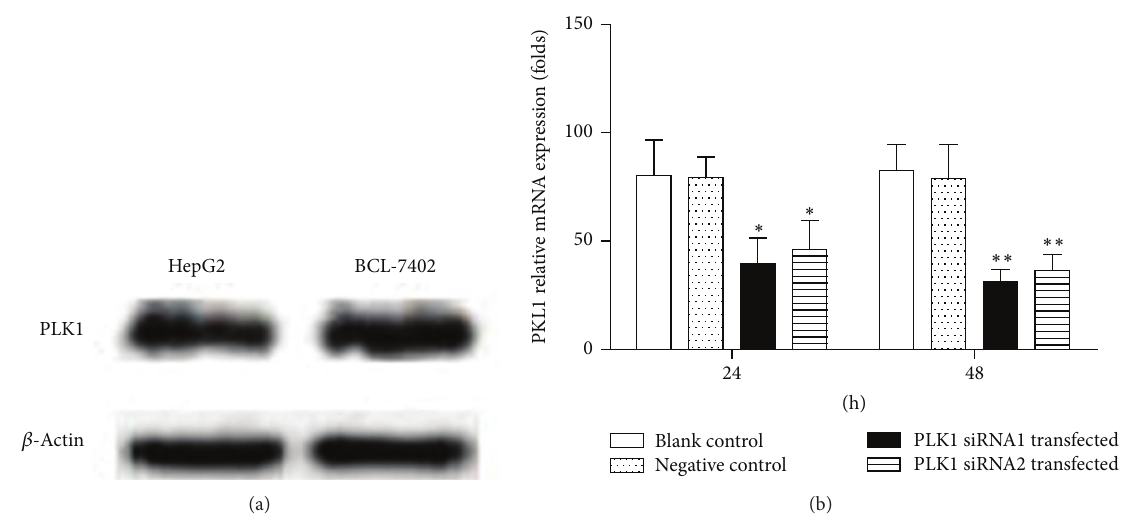
Figure 2: Polo-like kinase 1 (PLK1) expressions in hepatocellular carcinoma cell lines. (a) Western blot was used to determine the levels of PLK1 in HepG2 and BCL-7402 cell lines; beta-actin serves as the loading control. (b) Two designed siRNA for PLK1 were transfected to BCL-7402, respectively, and, 24h and 48 h later, cells were collected. The expressions of PLK1 were examined by real-time PCR. Results are shown as mean ± SD. Data are representative of at least 3 independent experiments. ∗ 𝑃 < 0.05 ; ∗∗ 𝑃 < 0.01 .